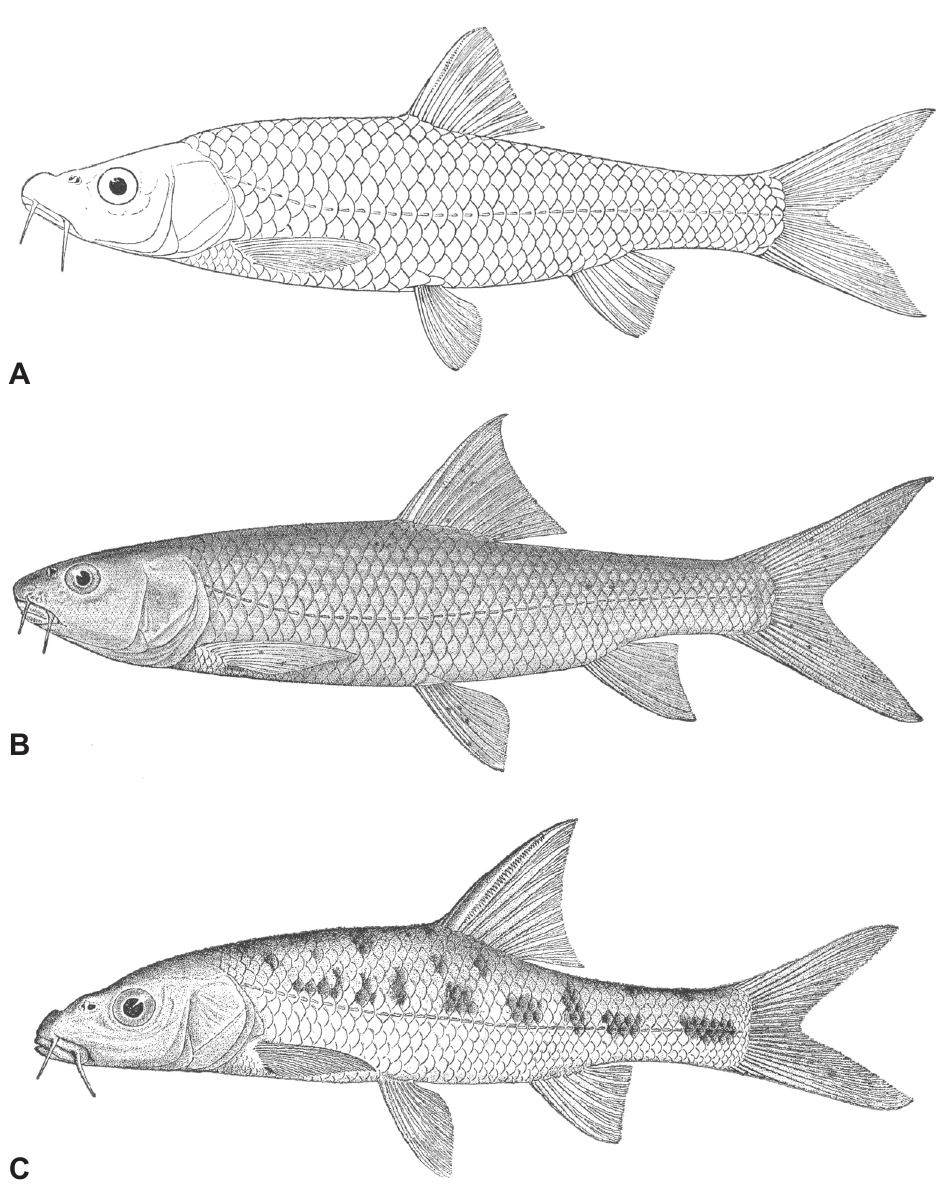
Fig. 3. A . Witvis, Barbus capensis now Cheilobarbus capensis Smith, 1841 (Gilchrist & Thompson 1913: fig. 70; Boulenger 1911: fig. 100). B . Clanwilliam yellowfish, Labeobarbus seeberi (Gilchrist & Thompson 1913: fig. 57; Boulenger 1916: fig. 150). C . Sawfin, Barbus serra now Cheilobarbus serra (Peters, 1864) (Gilchrist & Thompson 1913: fig. 61; Boulenger 1911: fig. 91), to show the overall body form and the form of the last unbranched dorsal-fin